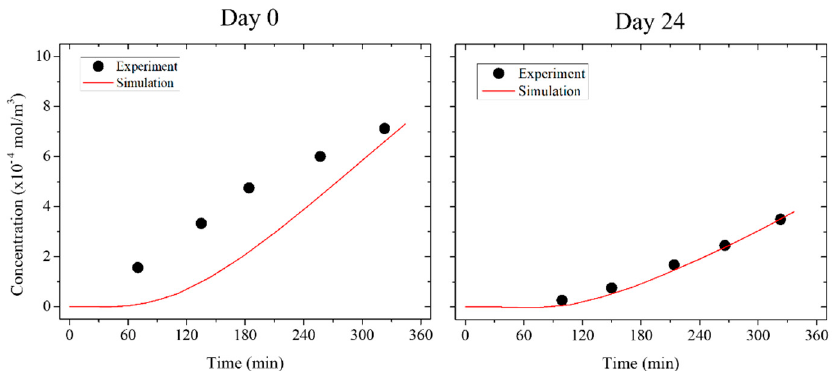
Figure 13. Comparison of the simulation with the permeation experiment. The diagrams show the donator concentration over time. The permeation of fluorescein sodium salt through the ftSE on day 0 (day of the ALI) and day 24 were determinant. The diffusion was calculated with numerical simulation by parameter adaption with Fick’s law. Table 3. Results of the calculated diffusion coefficient with the numerical simulation and the coefficient of determination ( r 2 ) regarding the experimental data. The diffusion of fluorescein sodium salt through the ftSEs at different cultivation times was investigated.